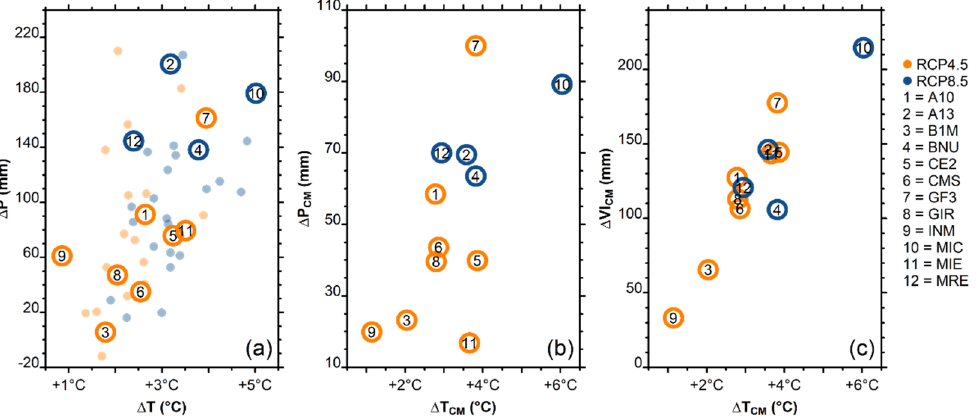
Figure 2. Changes ( Δ ) between the reference period (1981 − 2010) and the 2041 − 2070 horizon for the 12 selected climate scenarios in the study area in ( a ) annual precipitation ( Δ P) as a function of mean annual temperature ( Δ T) within the ensemble of 54 climate scenarios (27 RCP4.5 and 27 RCP8.5),